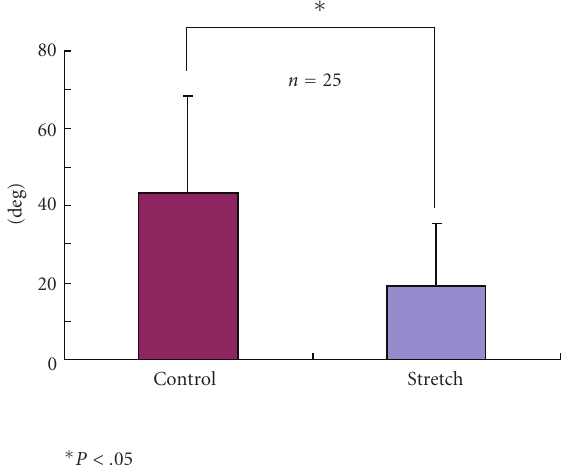
Figure 7: Actin filament directions of the cells in stretching groups were significantly lower degree than those of control groups ( P < . 05).